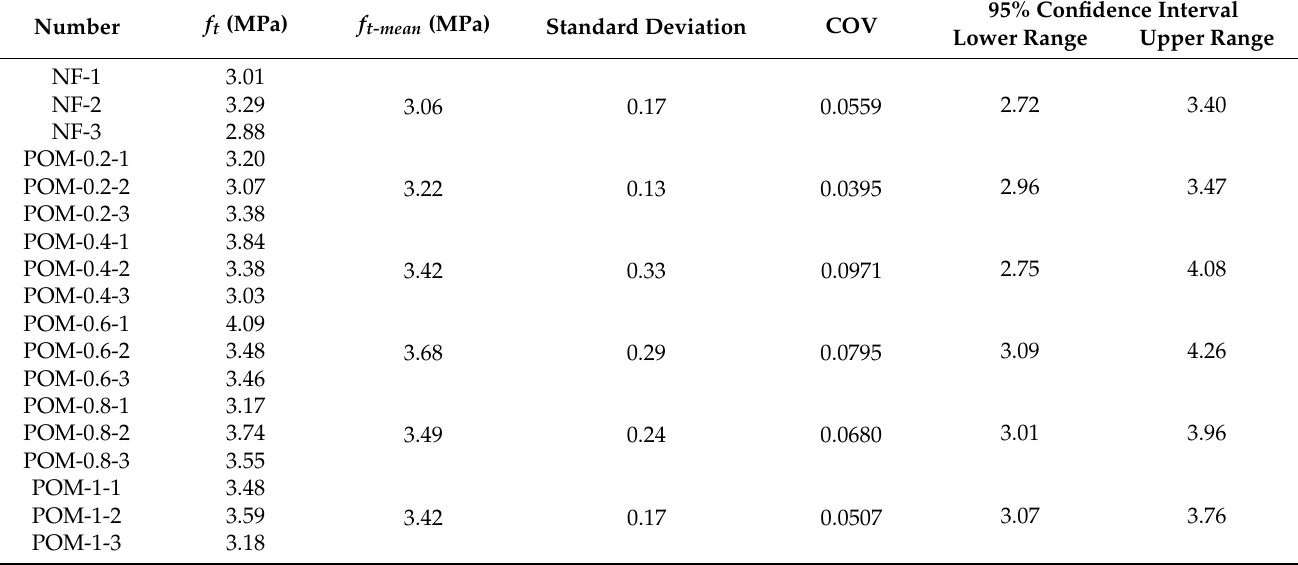
Table 10. Results of the splitting tensile tests of SWSSC with different